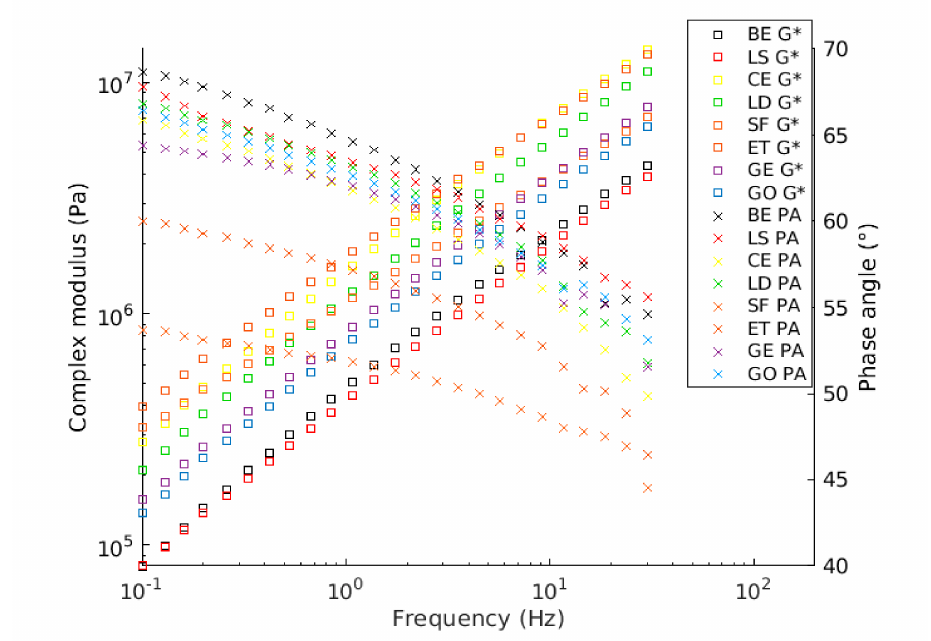
Figure 10. Frequency sweep output of Linear Amplitude Sweep (LAS) test at 20 ◦